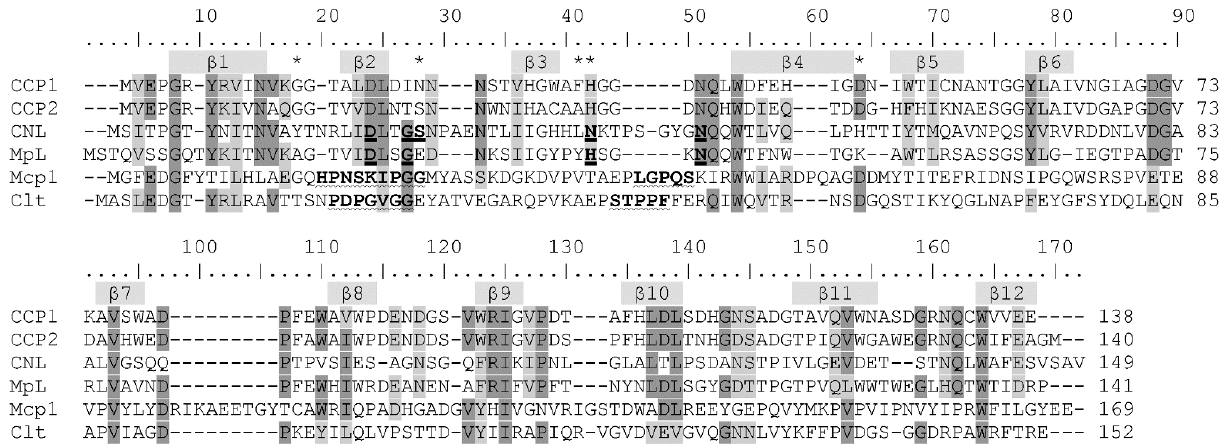
Figure 5. Alignment of amino acid sequences of cocaprins with selected lectins and mycocypins. Identical amino acid residues are shaded dark gray and similar ones are shaded light gray. The β -strands of cocaprin secondary structure are indicated by gray bars above the amino acid sequence. Glycan-binding residues of CNL and MpL are indicated in bold and underlined, and loops involved in inhibition of cysteine proteases by Clt and Mcp1 are indicated in bold and underlined with a wavy line. Asterisks indicate residues that were mutated in this study. The sequences were aligned with the BLOSUM62 matrix.